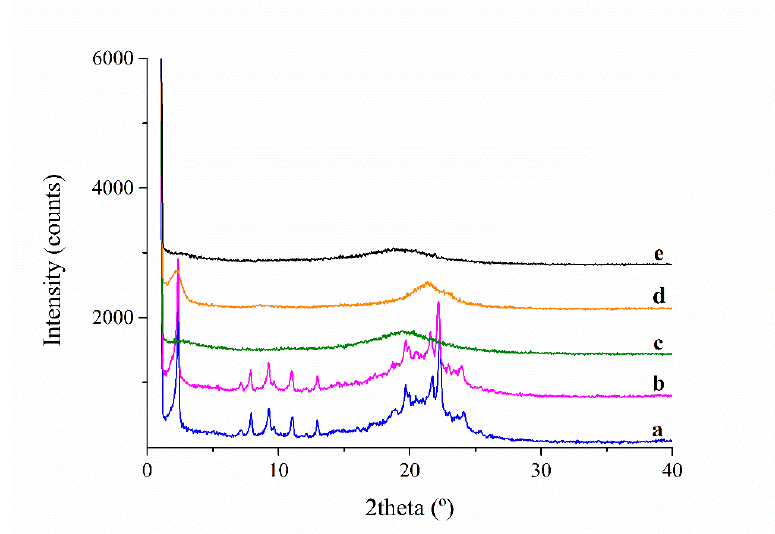
Figure 4. X-ray Diffraction (XRD) pattern of PAZE40: ( a ) native at 294 K; ( b ) after cooling to 223 K; ( c ) after subsequent heating to 353 K; ( d ) after second cooling to 233 K; ( e ) after second heating to 343 K.